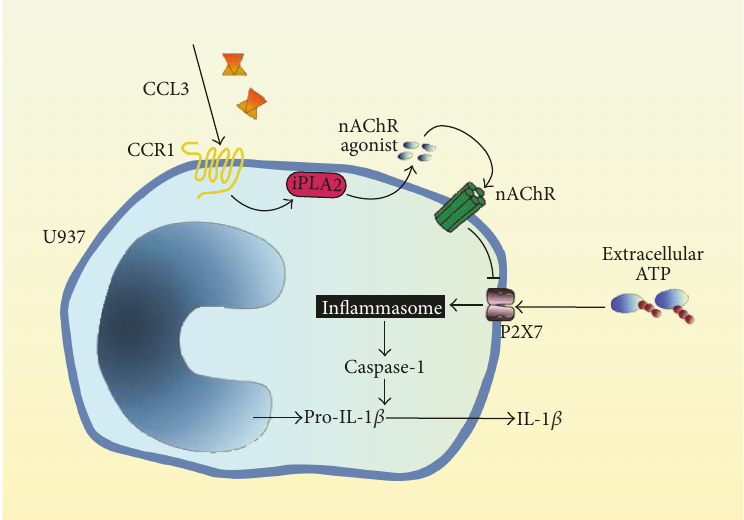
Figure 7: Schematic presentation of the proposed mechanism. The binding of extracellular ATP to P2X7 receptor on LPS-primed human monocytic U937 cells results in formation of a multiprotein complex called in fl ammasome that, in turn, activates caspase-1. Caspase-1 catalyzes the proteolytic maturation of pro-IL-1 β and enables the release of mature, bioactive IL-1 β . We propose that when U937 cells are stimulated with ATP and chemokine CCL3 concomitantly, chemokine receptor CCR1 activates the calcium-independent phospholipase A2 (iPLA2) and the secretion of a small agonist of nicotinic acetylcholine receptors (nAChR). Stimulation of nAChR containing subunits α 7 and α 9 inhibits P2X7 receptor function and, hence, maturation and secretion of IL-1 β . It is still unclear if nAChR subunits of monocytic cells actually form conventional pentamers as shown in the schematic